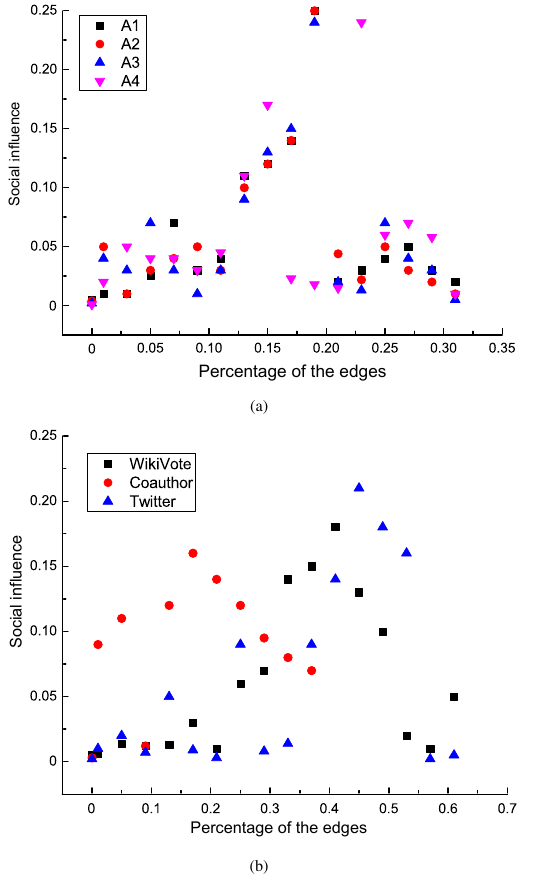
Fig. 12 Size of influential node set in (a) Amazon co- purchase data sets and (b) WikiVote, Coauthor, and Twitter data